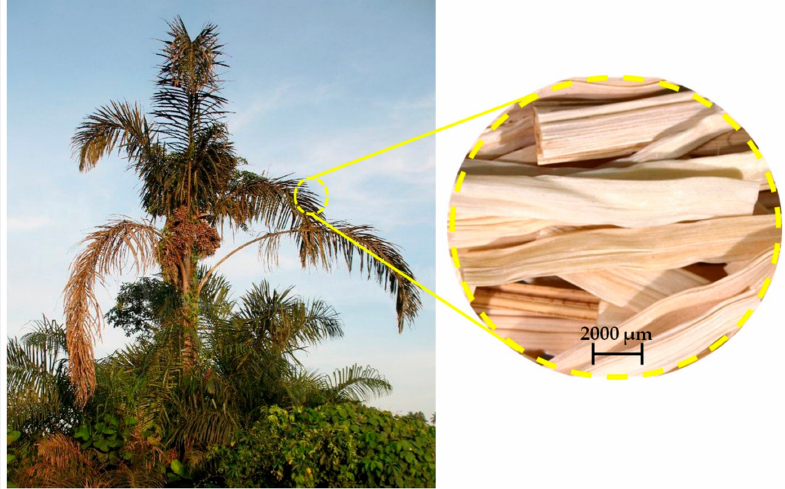
Figure 2. Raphia vinifera palm tree [44] and ra ffi a fiber extracted from the leaf